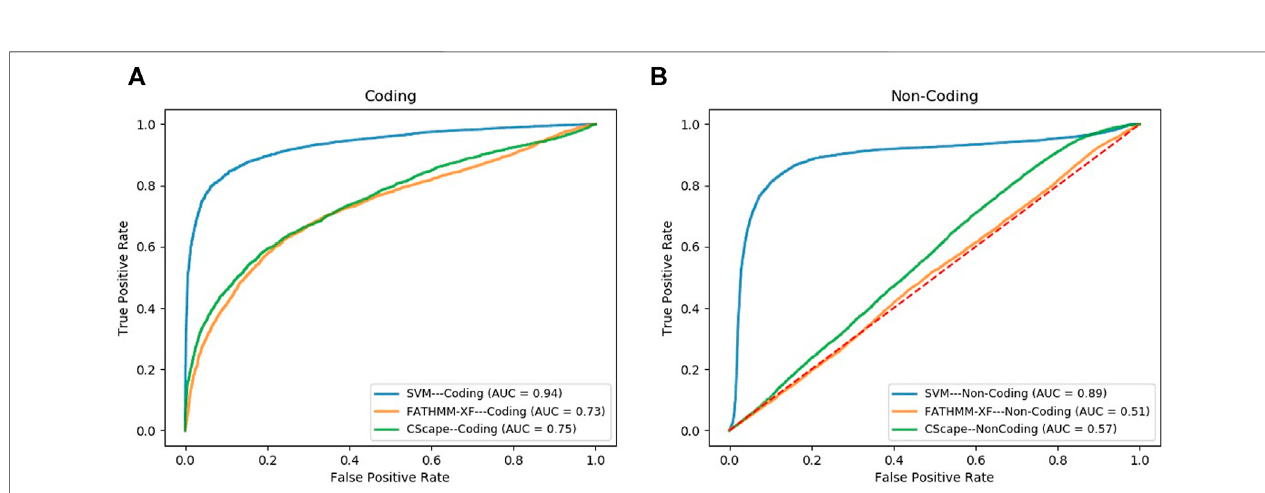
FIGURE3| ROCcurves comparingtheperformanceofourmodel (SVM) withFATHMM-XF and CScape for somatic cancervariants in coding (A) and non-coding (B) regions of the genome.